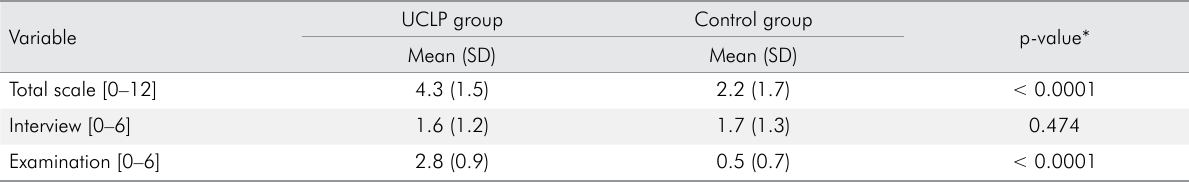
Table 1. Comparison of the NOT-S scores between groups. Variable